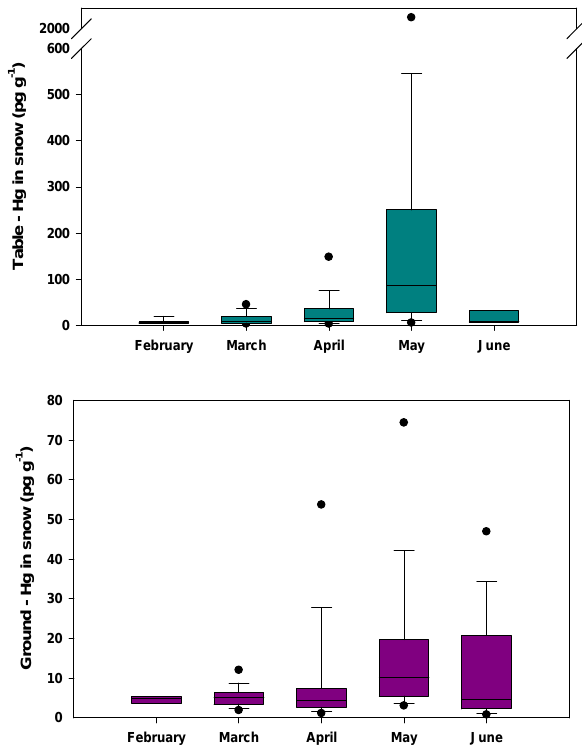
Fig. 7. Long-term snow sampling measurements at Alert from 1998 to 2011 sampled on an event basis. Samples are expressed as con- centration of mercury (pgg − 1 ) and were collected from a Teflon ® covered table (top – blue) and from the top layer of the snow pack (bottom – purple). The centre line in the box represents the median value, the boundaries of the box represent the 25th and 75th per- centiles, the whiskers represent the 10th and 90th percentile and the dots represent the 5th and 95th percentile.